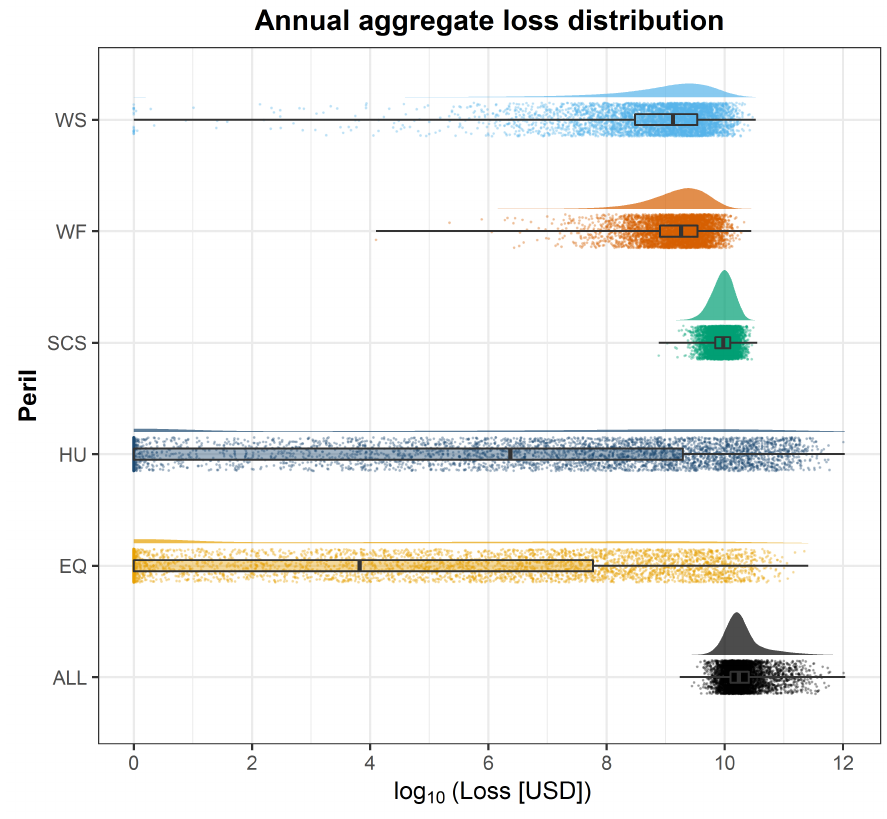
Figure 3. This figure displays results from a S = 500,000 year timeline simulation derived from the multi-peril frequency and severity model. The first 5 set of results displays annual aggregate losses for WS, WF, SCS, HU and EQ. The colored dots represent the annual aggregate losses overlaid by a bar indicating the minimum, maximum, median and interquartile ranges. A histogram is also provided for each peril. The final set of results labelled ALL displays the analogous results for all of the 5 perils aggregated